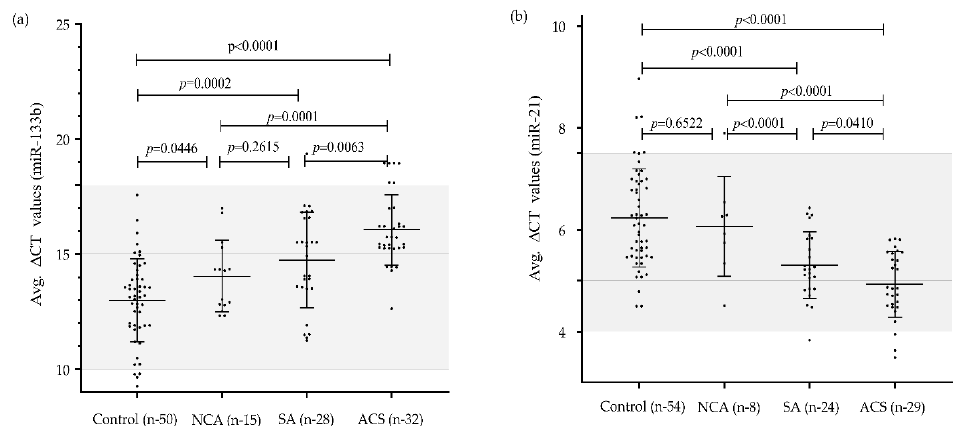
Figure 2. Mean expression values (delta-CT values) of miR-133b and miR-21 in di ff erent categories of CAD patients vs. control subjects: ( a ) Di ff erential gene expression (delta-CT values) of miR-133b in di ff erent clinical categories of CAD Patients vs. Control subjects. A significant di ff erential